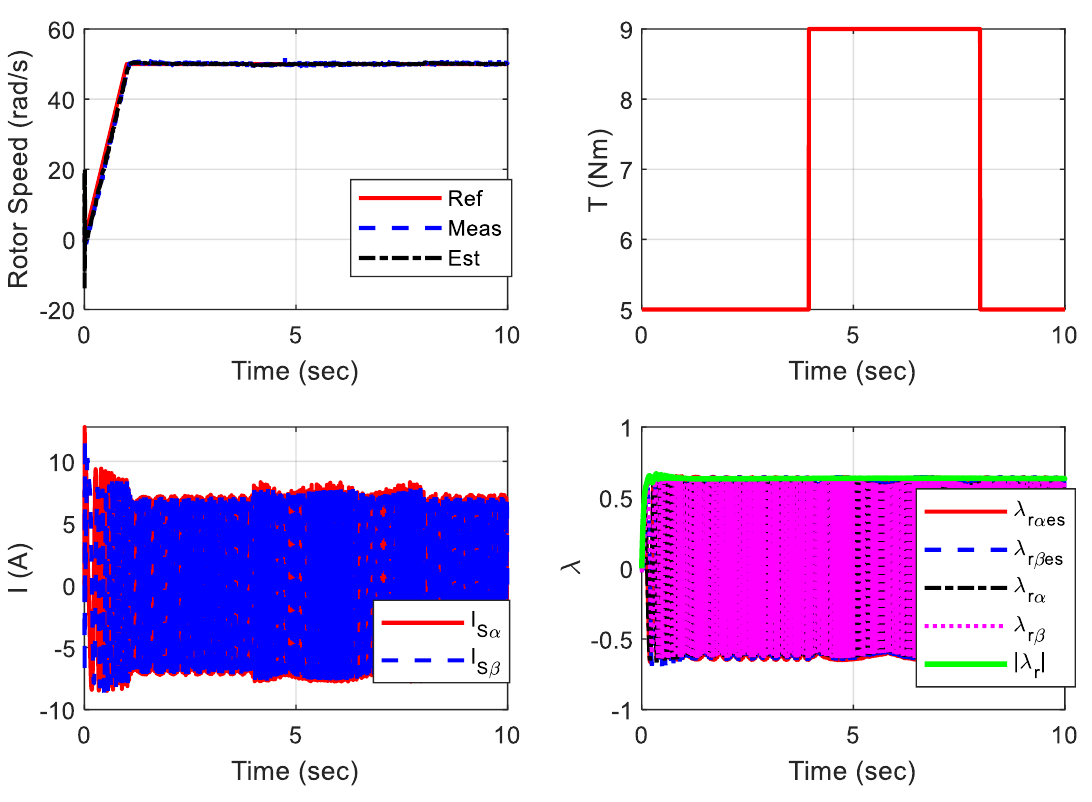
Figure 21. Response of the proposed drive with ANN-based estimators considering the case of pulse load torque disturbance.